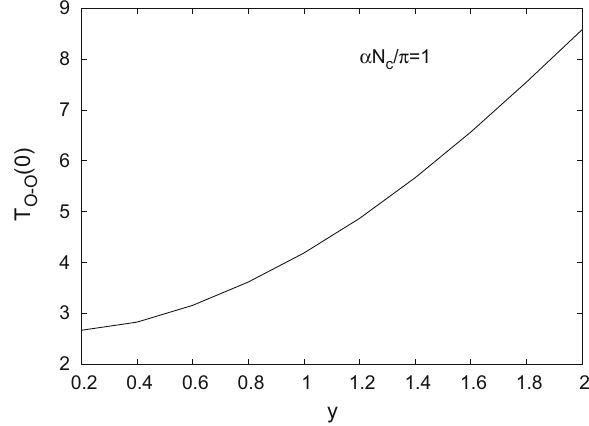
Fig. 9 Eikonal T ( 0 ) for central O–O collisions at Y = 2 with the quadruple pomeron interaction S 4